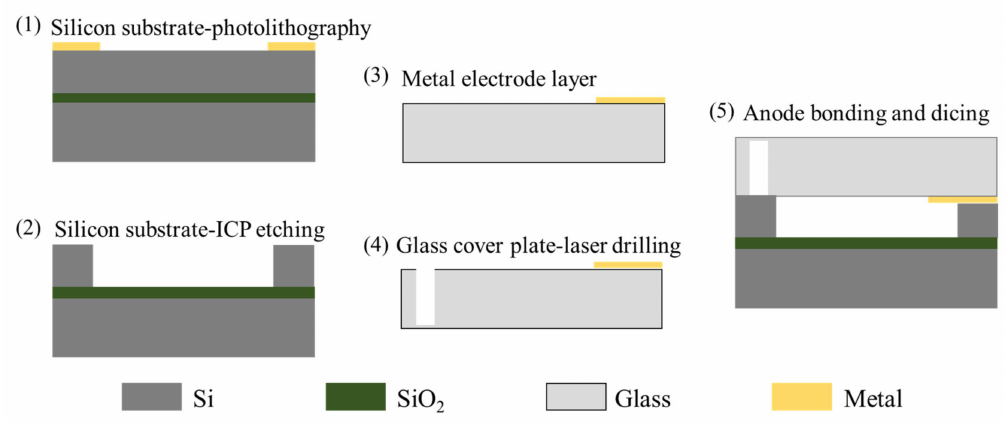
Figure 13. The special fabrication method for a liquid inertial